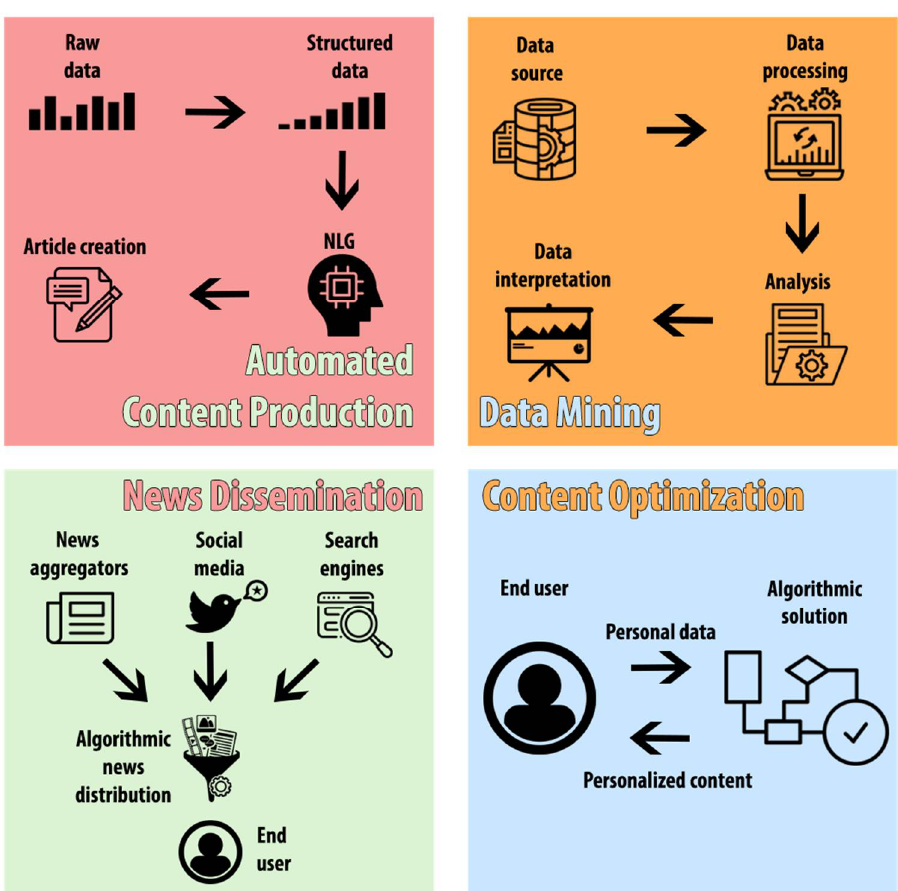
Figure 1. Fields of application for algorithmic journalism.